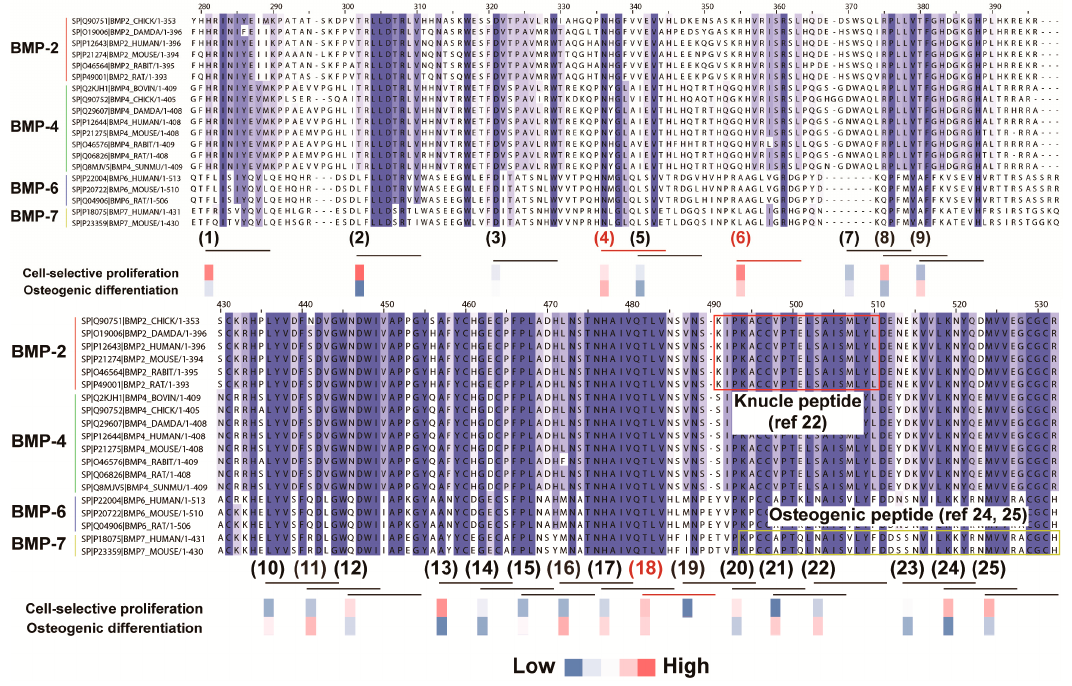
Figure 7. Location of osteogenic-enhancing peptides. The results of osteogenic cell-selective proliferation and osteogenic differentiation peptides and their locations in the BMP sequences are indicated.